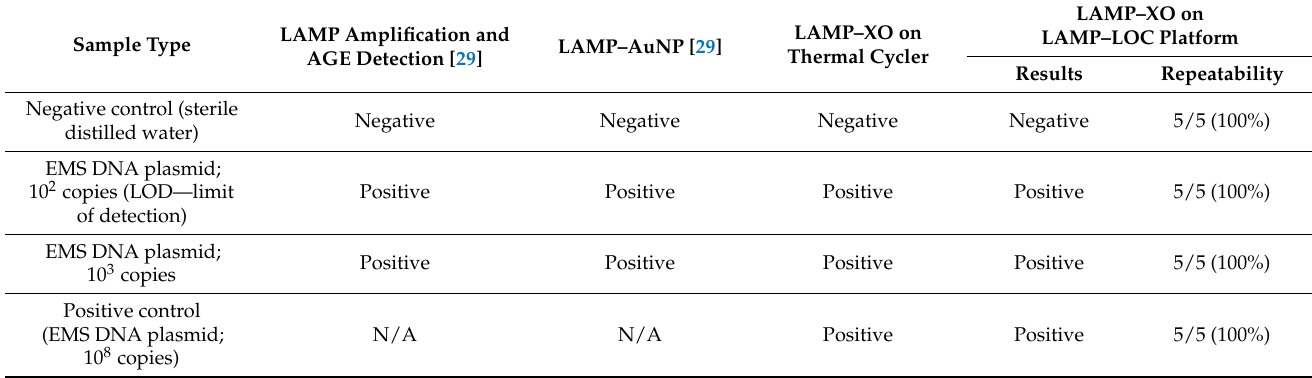
Figure 16. The experimental results, illustrating positive detection of EMS at 10 2 , 10 3 and 10 8 copies. Table 6. Sensitivity test results of early mortality syndrome detection by LAMP–XO EWOD platform compared to the other standard LAMP tests.